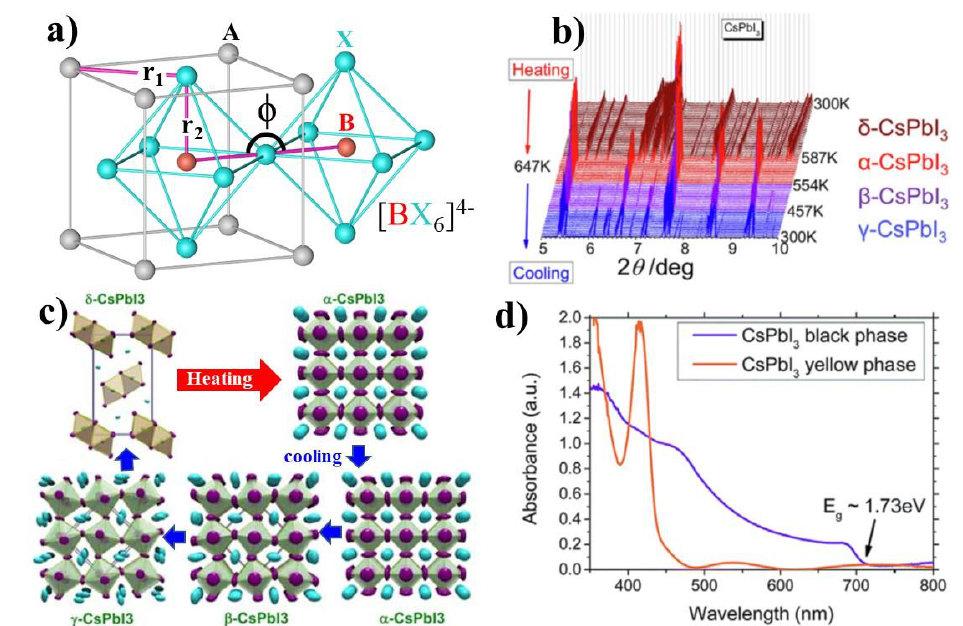
Figure 2. ( a ) Crystal structure of ABX 3 . The label r 1 = r A − x , r 2 = r B − x and φ = B − X − B (Pb − I − Pb); ( b ) Synchrotron XRD patterns of CsPbI 3 at different temperatures. ( c ) Schematic illustration of crystal phase transitions in CsPbI 3 upon temperature cycle. ( b , c ), adopted with permission from Ref. [53], Copyright 2018 American Chemical Society. ( d ) UV – vis absorption spectra of black-phase and yellow-phase CsPbI 3 thin films. Adopted with permission from Ref. [32], Copyright 2015 Royal Society of Chemistry.